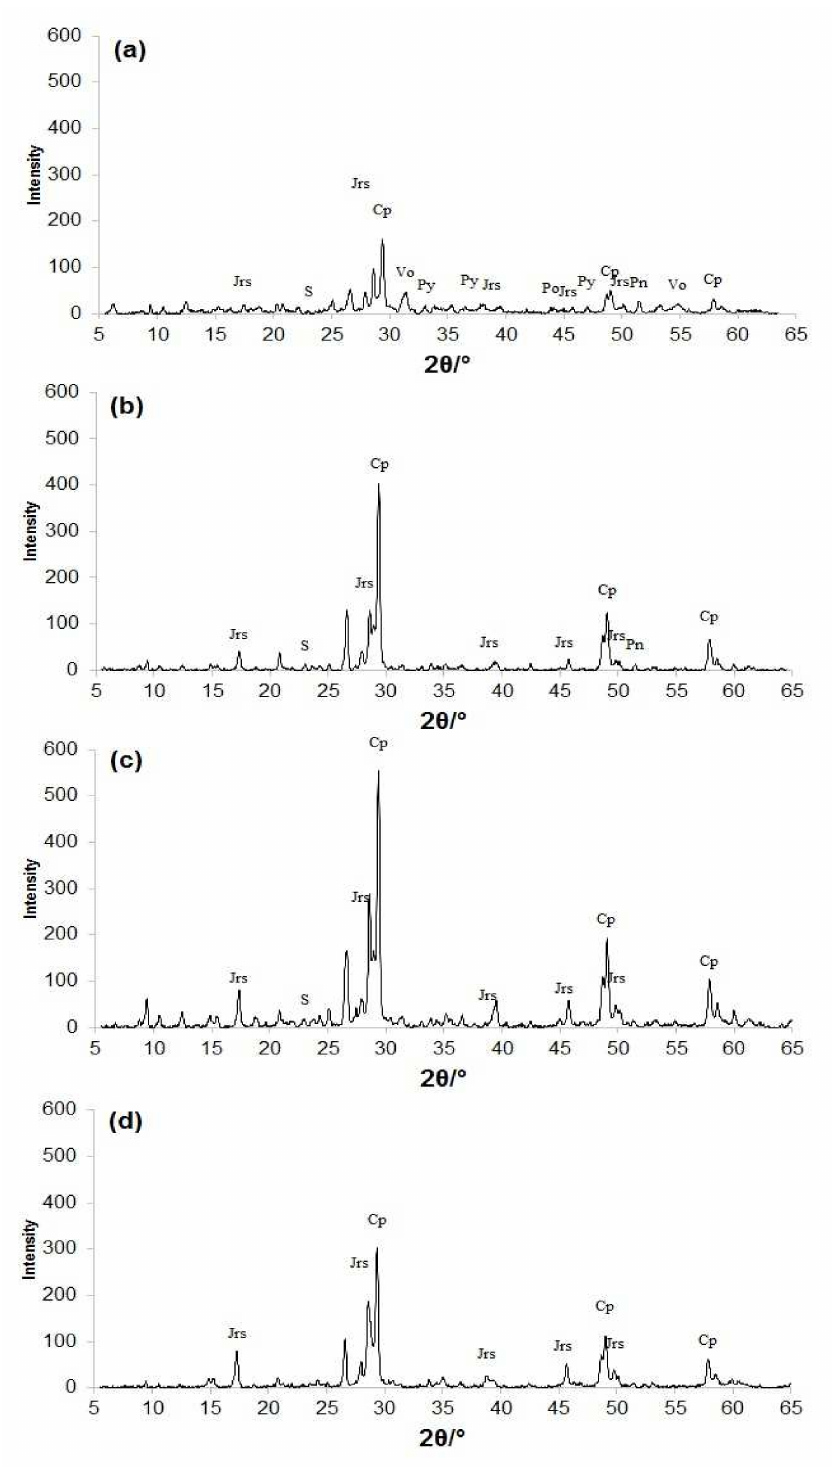
Figure 4. XRD patterns ( a ) of the original concentrate and bioleach residues at ( b ) 35, ( c ) 40, and ( d ) 50 ◦ C (Pn, pentlandite; Vo, violarite; Cp, chalcopyrite; Py, pyrite; Po, pyrrhotite; S, elemental sulfur; Jrs,